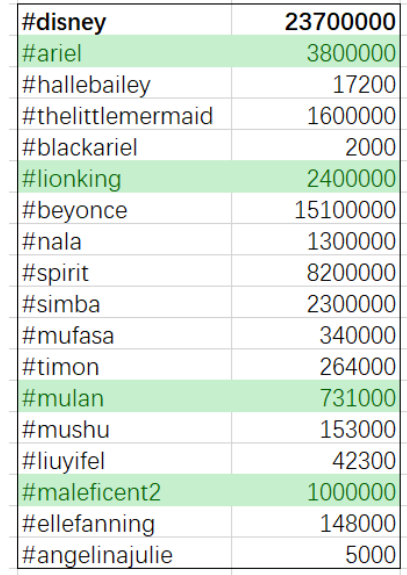
Figure 16 Dataset of event